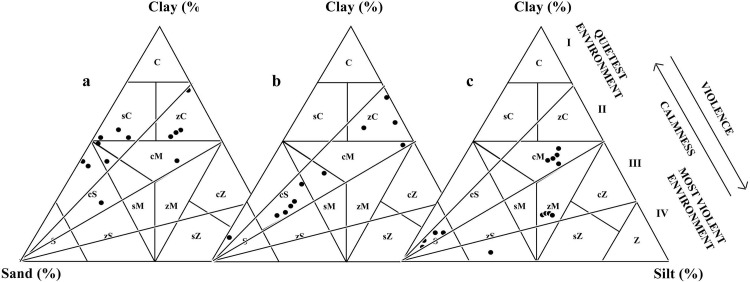
Sediment types based on Picard [15] of the borehole cores retrieved from the study area, a) Vettiyar, b) Puvathur and c) Karippumuri kadavu and also showing depositional environment suggested by Pejrup [21].